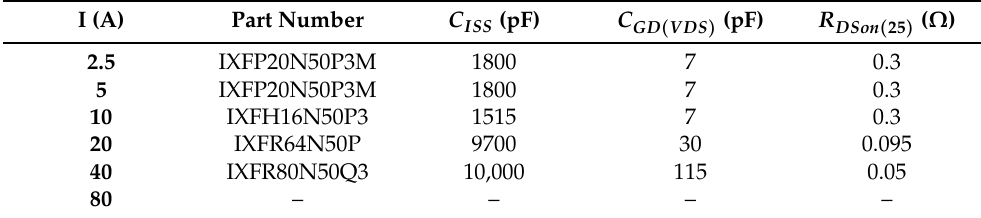
Table 6. Characteristics of selected Si